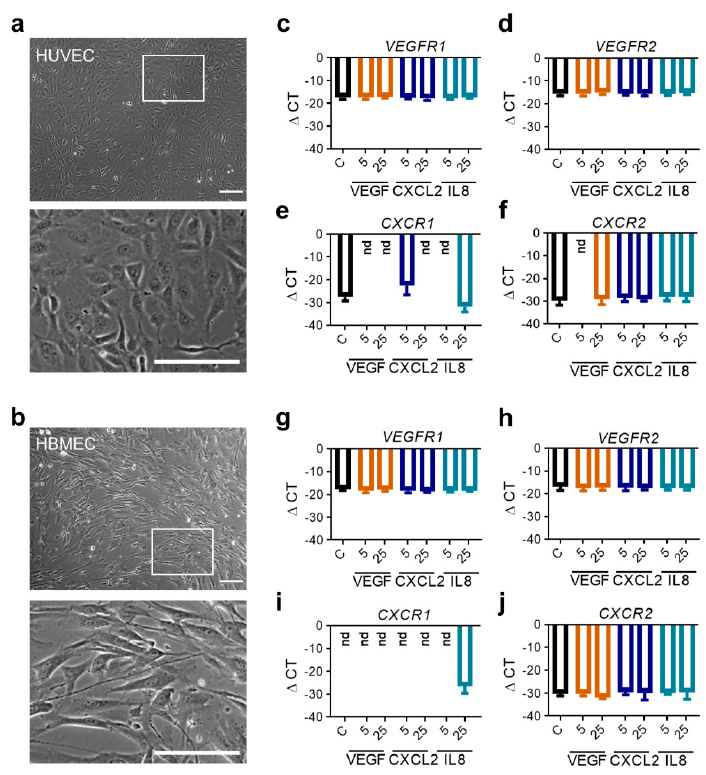
Figure 3. RNA expression analyses of angiogenic receptors in human endothelial cells following stimulation with angiogenic molecules. ( a , b ) Morphology of HUVEC ( a ) and HBMEC ( b ) in culture taken by phase contrast microscopy. Scale bars 150 µm, squares: identified magnified areas. ( c - j ) HUVEC ( c - f ) and HBMEC ( g - j ) were stimulated with VEGF, CXCL2 or IL8 in indicated concentrations for 24 h. Analysis of mRNA expression regarding the indicated proangiogenic receptors are depicted ( n = 9/condition out of three independent experiments). nd: not detected. 2.4. Mobilization of Endothelial Cells by the Classical Proangiogenic Factor VEGF in Comparison to the Alternative Molecules CXCL2 and IL8 The positive effect of VEGF on endothelial cells is well known, while influence by CXCL2 and IL8 is analyzed to a lesser extent [36,37]. Hence, we evaluated the proliferative and migratory activity of human endothelial cells in reaction to these molecules. Counting cells following stimulation with angiogenic factors revealed that VEGF as well as CXCL2 and IL8 were able to induce proliferation of HUVEC (Figure 4a,b). Colorimetric analysis showed a dose-dependent increase in proliferative activity if rising concentrations of VEGF were added, while CXCL2 and IL8 resulted in enhanced proliferation by using spe- cific molecule concentrations (Figure 4c). Additionally, investigation of the endothelial cell migration revealed that both factors significantly improved the motility of HUVEC in a dose-dependent manner, even though CXCL2 and IL8 did not reach the high level of migratory response as mediated by VEGF (Figure 4d,e). Consequently, CXCL2 and IL8 can induce proliferation and mobilization of primary endothelial cells but with lesser po- tency than VEGF.